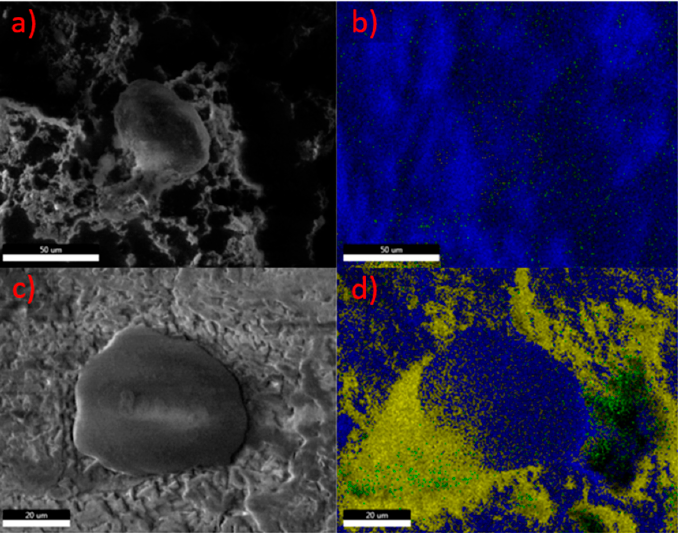
Figure 15. SEM-EDX analysis of dry water (DW 9:1 ) in ( a ) and ( b ) as well as dry water capsule on sand particle surface in ( c ) and ( d ). Furthermore, ( a ) and ( c ) are live map images; ( c ) and ( d ) display the element overlay. The following elements are visible: oxygen (blue), silicon (yellow) and carbon (green).